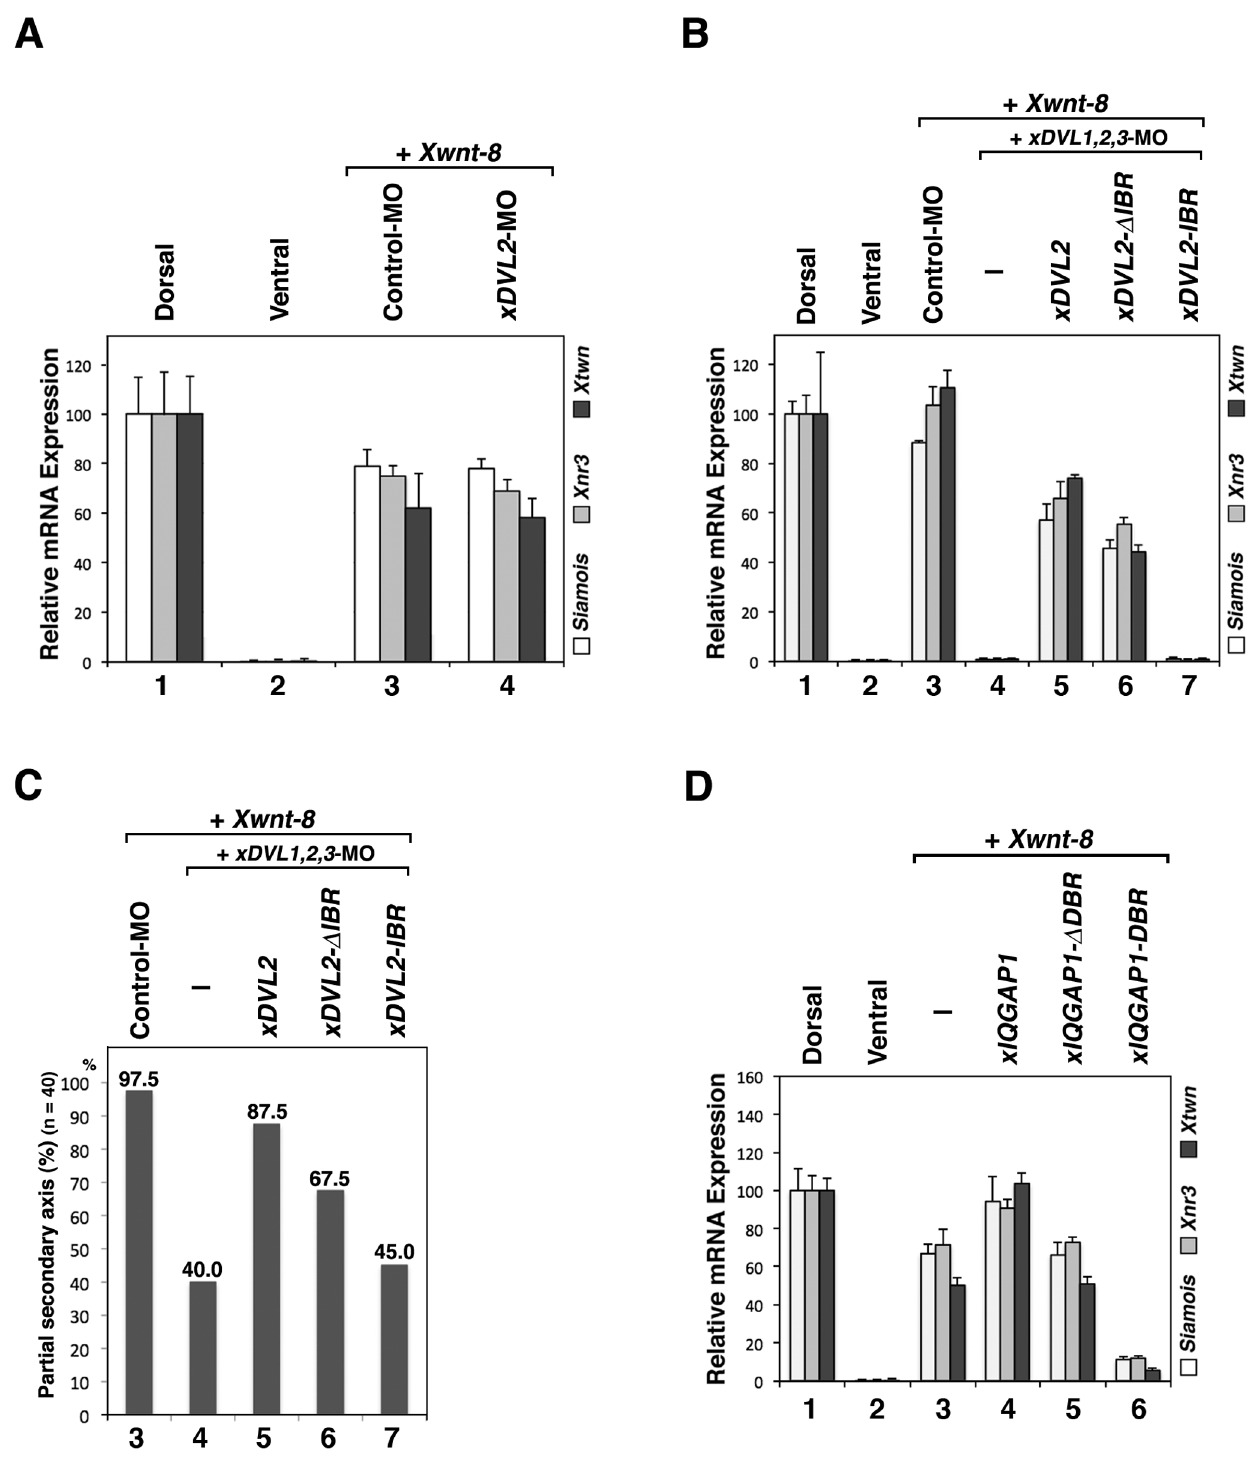
Figure 5. The role of the xIQGAP1-binding region of xDVL2 in canonical Wnt signaling during early embryogenesis. ( A ) Quantitative RT-PCR analysis of early dorsal Wnt target genes (n=3). Control-MO (15 ng) or xDVL2 -MO (15 ng) was ventrally co-injected with Xwnt-8 (0.5 pg) mRNA. RNAs from dissected ventral sectors of injected embryos were extracted at stage 10. The following procedure is indicated in Figure 4A. Error bars represent standard deviation of the mean in three experiments. Statistical significance was determined by Student’s t -test for each marker gene. The highest P values in three marker genes were chosen as a representative, as follows: P . 0.1 [between lane 3 and lane 4]. ( B ) Quantitative RT-PCR analysis of early dorsal Wnt target genes (n=3). xDVL1 -MO (10 ng), xDVL2 -MO (10 ng), xDVL3 -MO (10 ng) and Xwnt-8 (0.5 pg) mRNA were ventrally co-injected with xDVL2 constructs: xDVL2 (25 pg), xDVL2- D IBR (25 pg), xDVL2-IBR (25 pg) mRNA. RNAs from dissected ventral sectors of injected embryos were extracted at stage 10. The following procedure is indicated in Figure 4A. P , 0.05 [between lane 3 and lane 4], P , 0.05 [between lane 4 and lane 5], P , 0.1 [between lane 5 and lane 6], P , 0.05 [between lane 5 and lane 7]. ( C ) The ratio of injected embryos that exhibited a partial